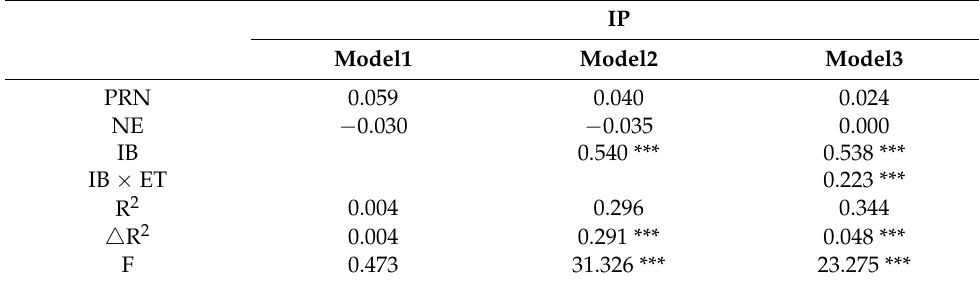
Table 6. Results of the moderating